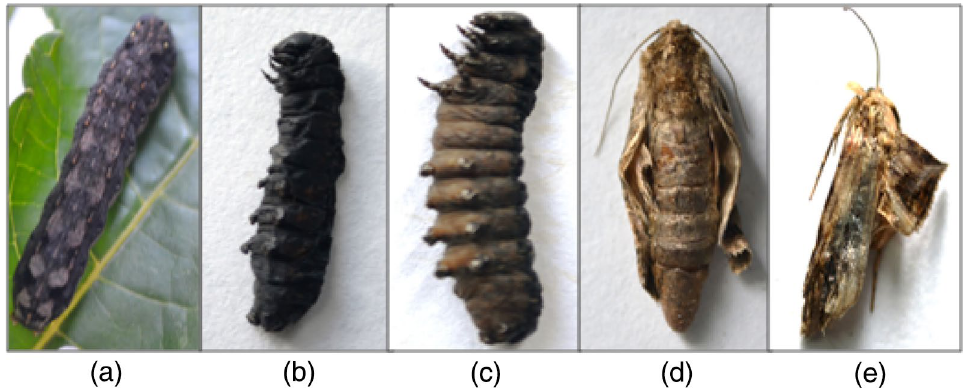
Figure 5. Effect of bacterial infection on S. litura ( a ) healthy (control) larva, ( b , c ) dead larvae, ( d , e ) morphologically deformed